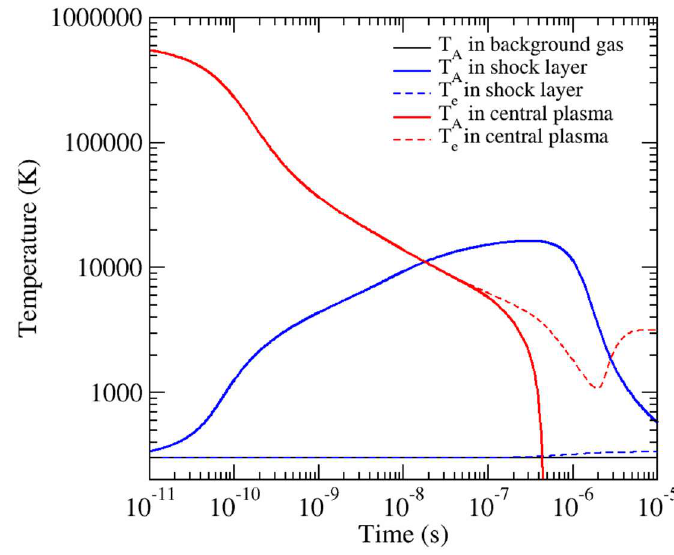
Figure 10. Same as Figure 8, but for the temperatures.